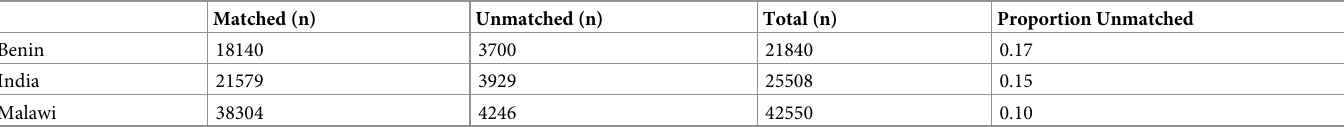
Table 1. Proportion of School-Age Children in DeWorm3 Catchment Areas with Unmatched School Names, by Study Site. Matched